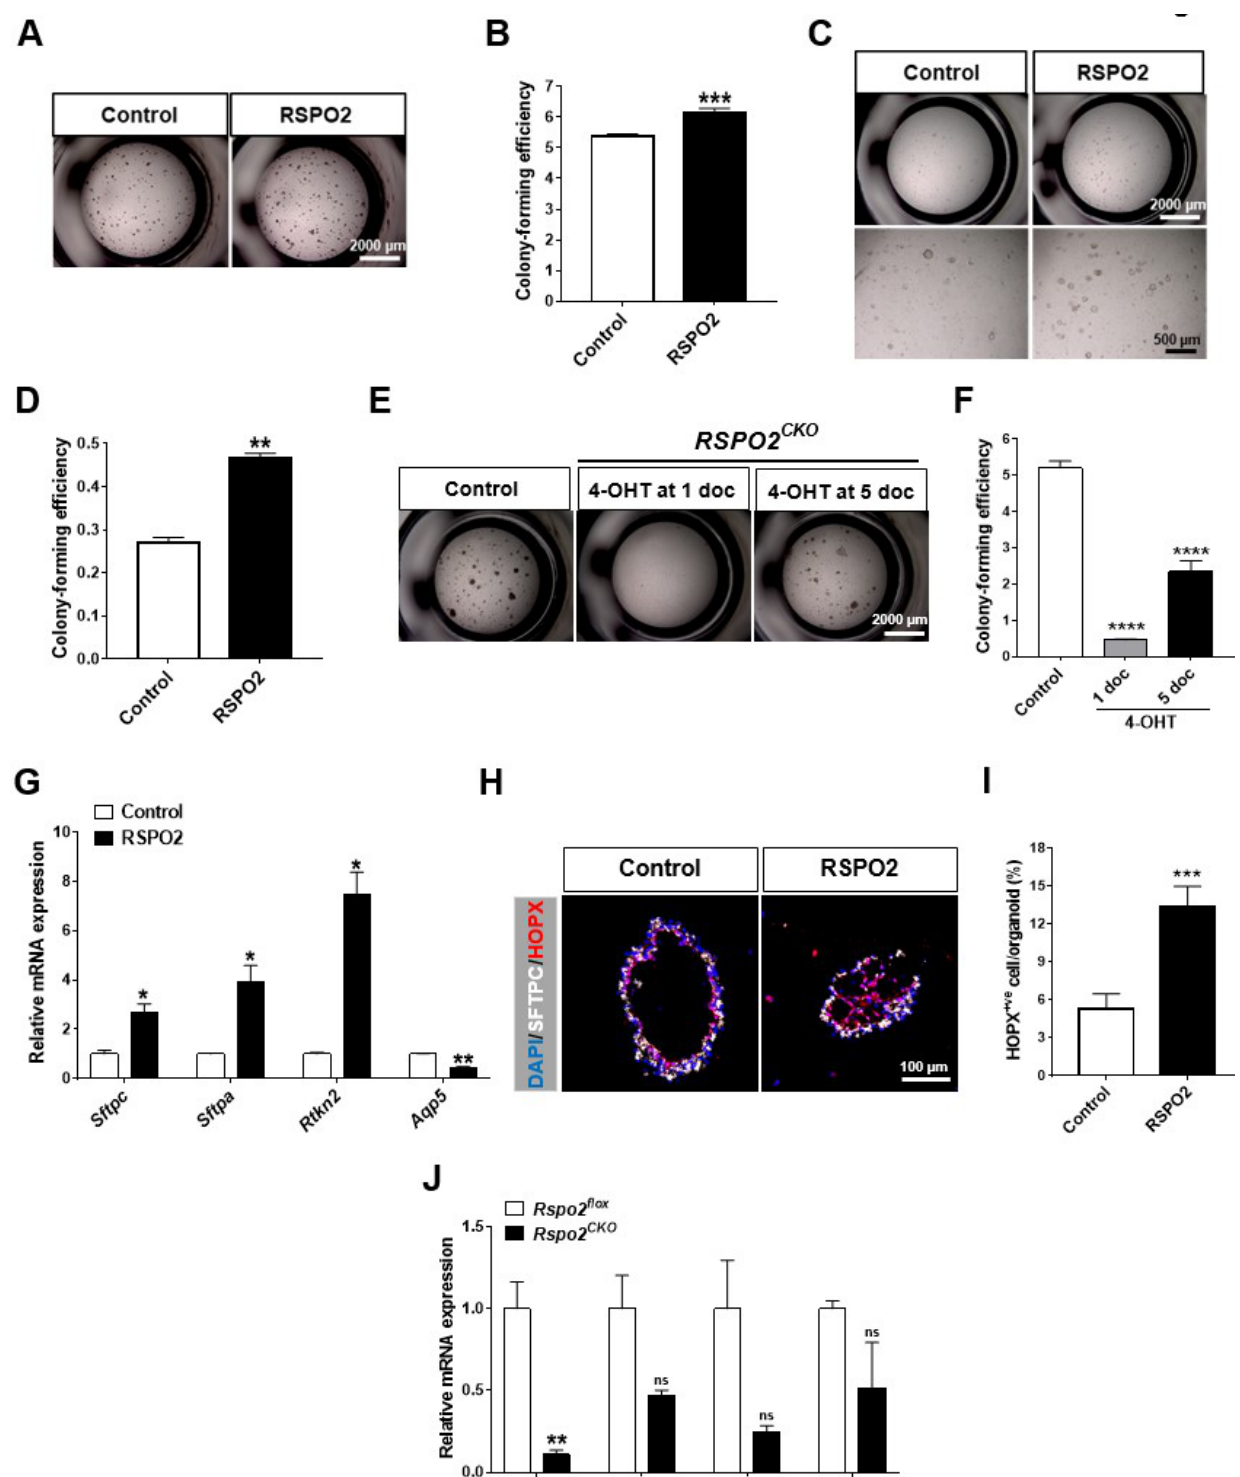
Figure 6. RSPO2 is essential for the colony formation and differentiation of AT2 cells in ex vivo 3D organoid culture. ( A , B ) Bright-field images and colony-forming efficiency of AT2 cells in ex vivo 3D organoid culture treated with in RSPO2 (200 ng/mL). ( C , D ) Bright-field images and quantification of colony forming efficiency of AT2 cells in a fibroblast-free, FGF10/HGF supplemented 3D organ- oid culture in the presence of RSPO2 (200 ng/mL). ( E , F ) Bright-field images and colony-forming efficiency of Rspo2 CKO AT2 cells in the organoid culture. 4-OHT (500 nM) was administered for a total of two days beginning at day 1 or day 5 of organoid culture. ( G ) qRT-PCR analysis of AT2 cell